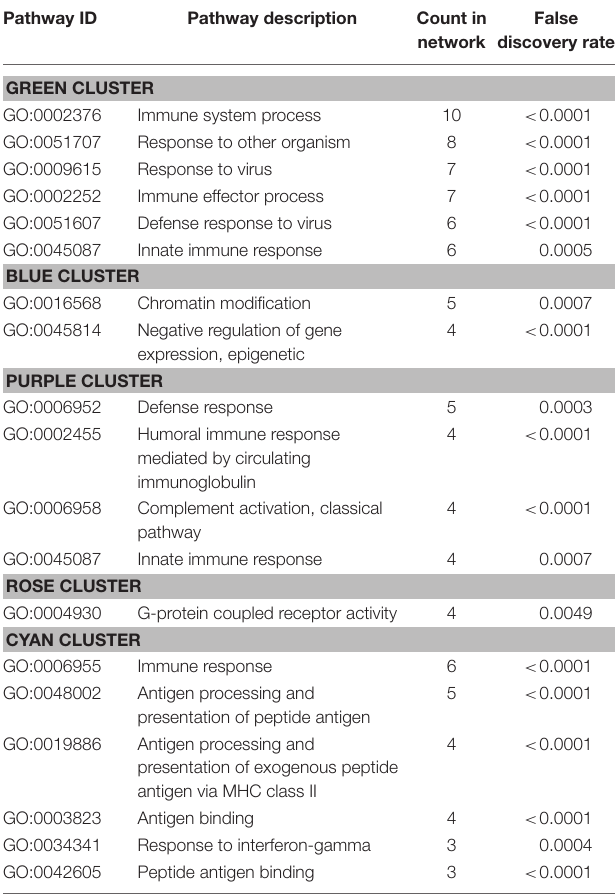
TABLE 6 | GO biological processes and molecular functions of PPI-clusters from downregulated mRNAs in α -Gal A ( − / 0) vs. wildtype mice. Pathway